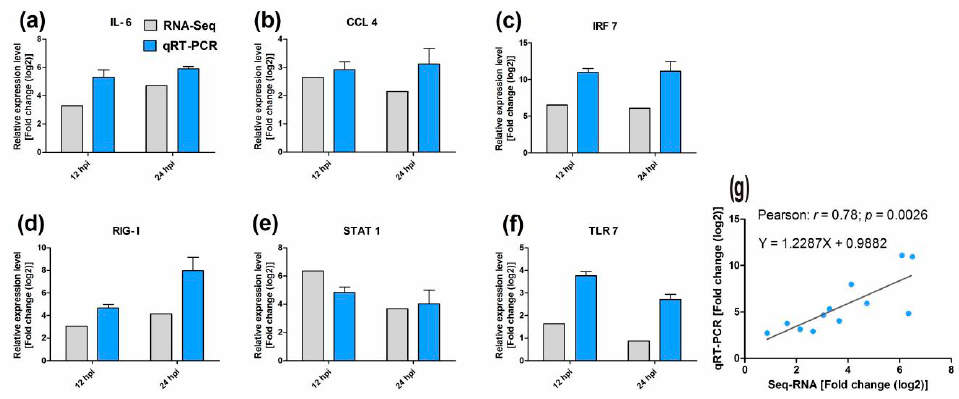
Figure 9. Confirmation of the transcriptome sequencing data by quantitative real-time (qRT)-PCR. Six differentially expressed genes (DEGs) involved in immune-related pathways were selected for qRT-PCR, and expression was estimated using the 2 − ∆∆ CT method. The qRT-PCR data are presented as the mean ± standard deviation ( n = 5) ( a – f ). Pearson’s correlation analyses of the expression of above six DEGs between Seq-RNA and qRT-PCR ( g